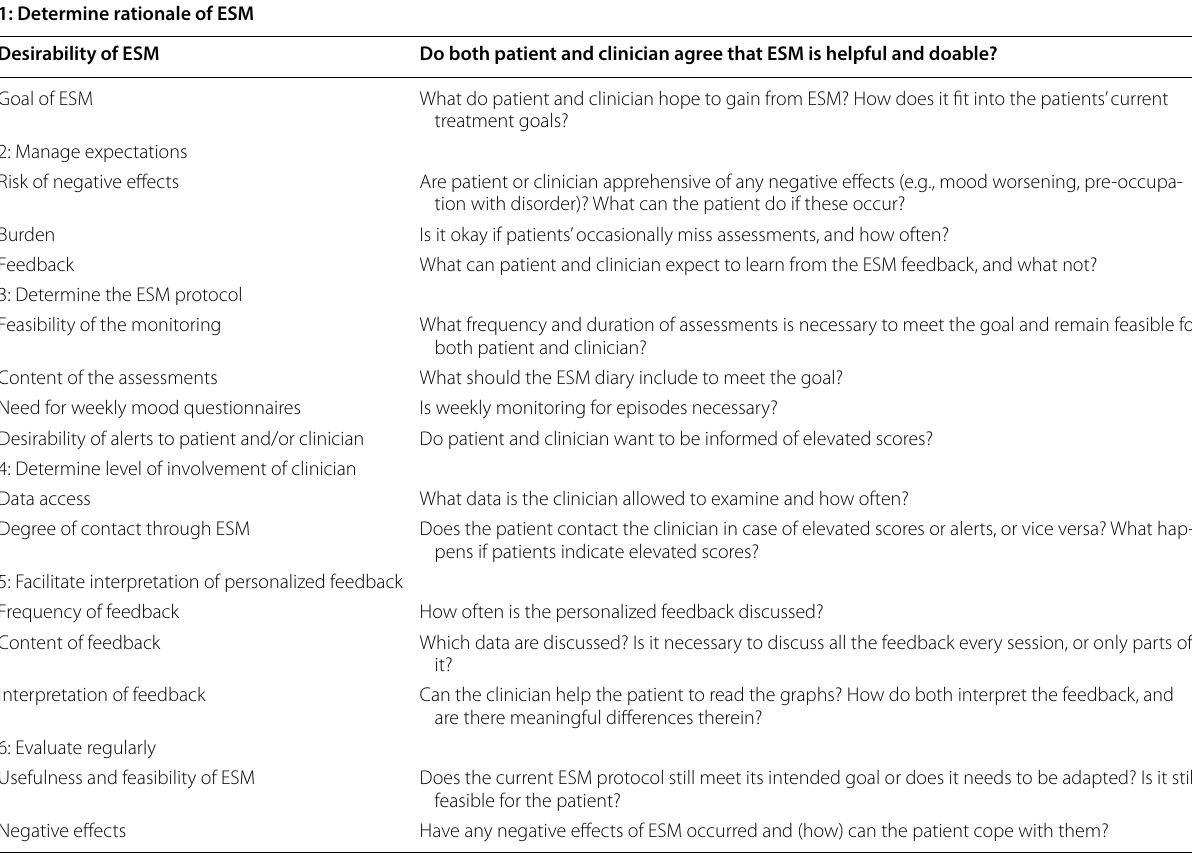
Table 4 Practical discussion points for clinicians and patients to consider before starting ESM in treatment, based on the findings of the present